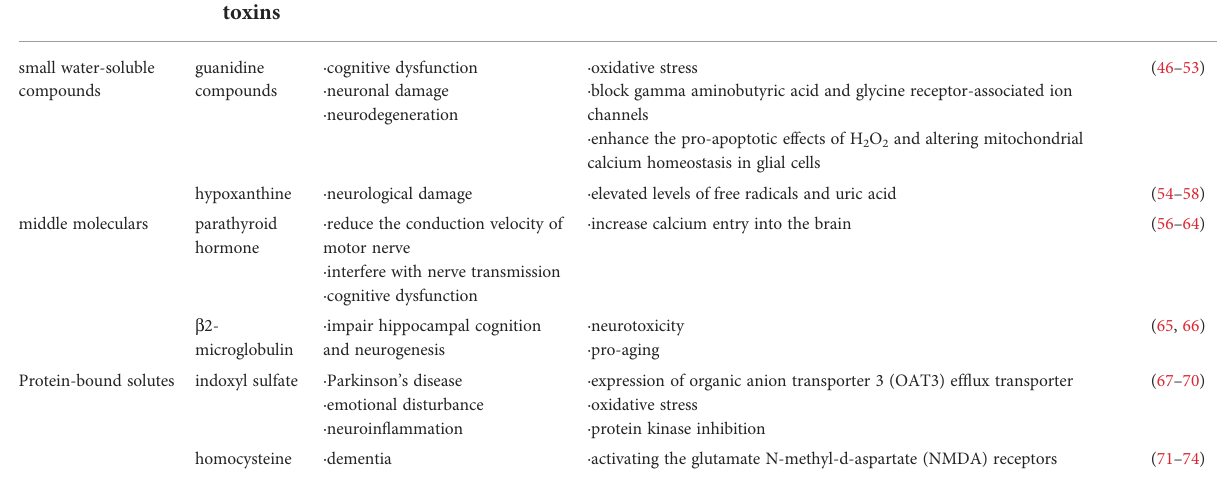
TABLE 2 The uremic toxins affecting neurogoical disorder.